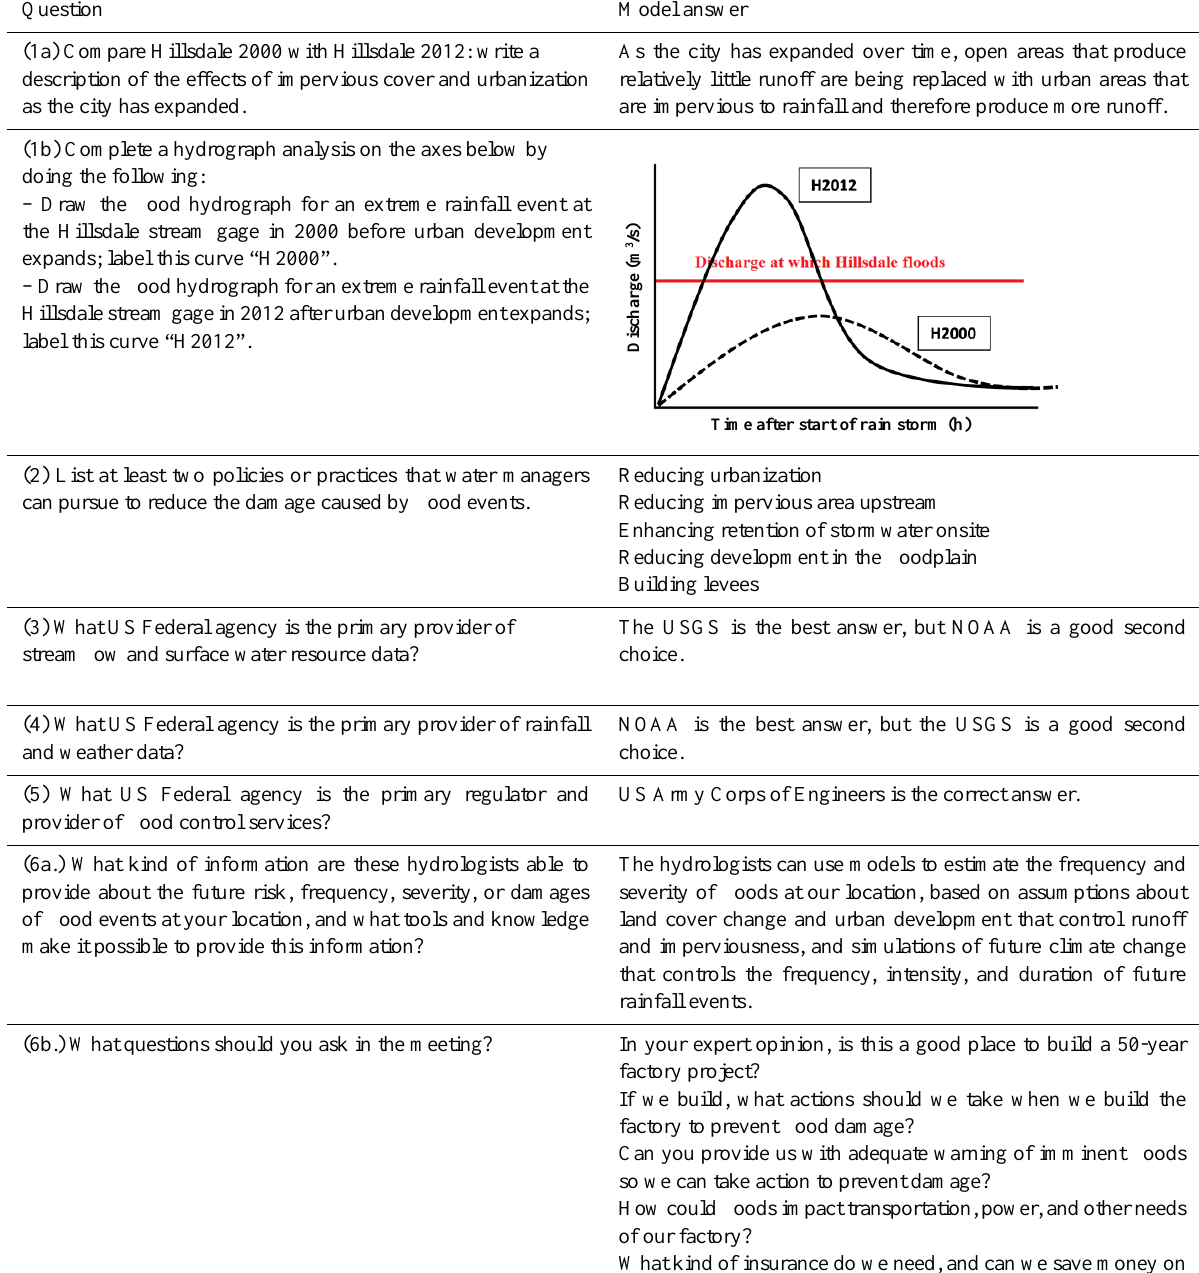
Table 1. Pre/Post Assessment Instrument with Model ‘Expert’ Answers 1 Table 1. Pre-/post-assessment instrument with model “Expert” answers. Question Model